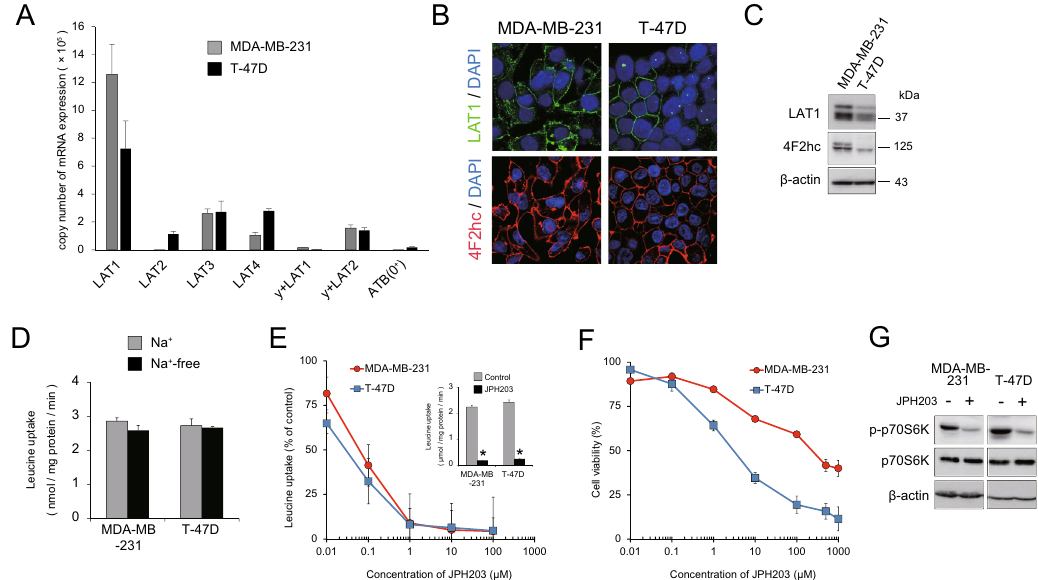
Figure 1. Expression of LAT family and effect of JPH203 in MDA-MB-231 and T-47D cells. ( A ) Copy number of leucine transporter mRNA in MDA-MB-231 and T-47D cells by qPCR. ( B ) Immunocytochemistry of LAT1 and 4F2hc in MDA-MB-231 and T-47D cells. Upper columns: LAT1 (green) and DAPI (blue; nuclear staining), lower columns: 4F2hc (red) and DAPI. Scale bars = 20 μm. ( C ) Western blot analysis of LAT1 and 4F2hc in MDA-MB-231 and T-47D cells. ( D ) Radio-labeled leucine uptake was measured in normal Na + -containing or Na + -free buffer. ( E ) Radio labeled l-leucine uptake was measured under condition of 0.01–100 μM JPH203. The inset showed leucine uptake at a concentration of 1 μM JPH203 in MDA-MB-231 and T-47D cells. *p < 0.05. ( F ) MDA-MB-231 and T-47D cells were incubated for 4 days in the presence of indicated concentration of JPH203, and cell viability was assessed by MTT colorimetric assay. ( G ) MDA-MB-231 and T-47D cells were incubated for 12 h in the absence or presence of 100 μM (MDA-MB-231) and 5 μM (T-47D) of JPH203. The cell lysates were subjected to western blot analysis for phospho-p70S6K, a target molecule downstream of